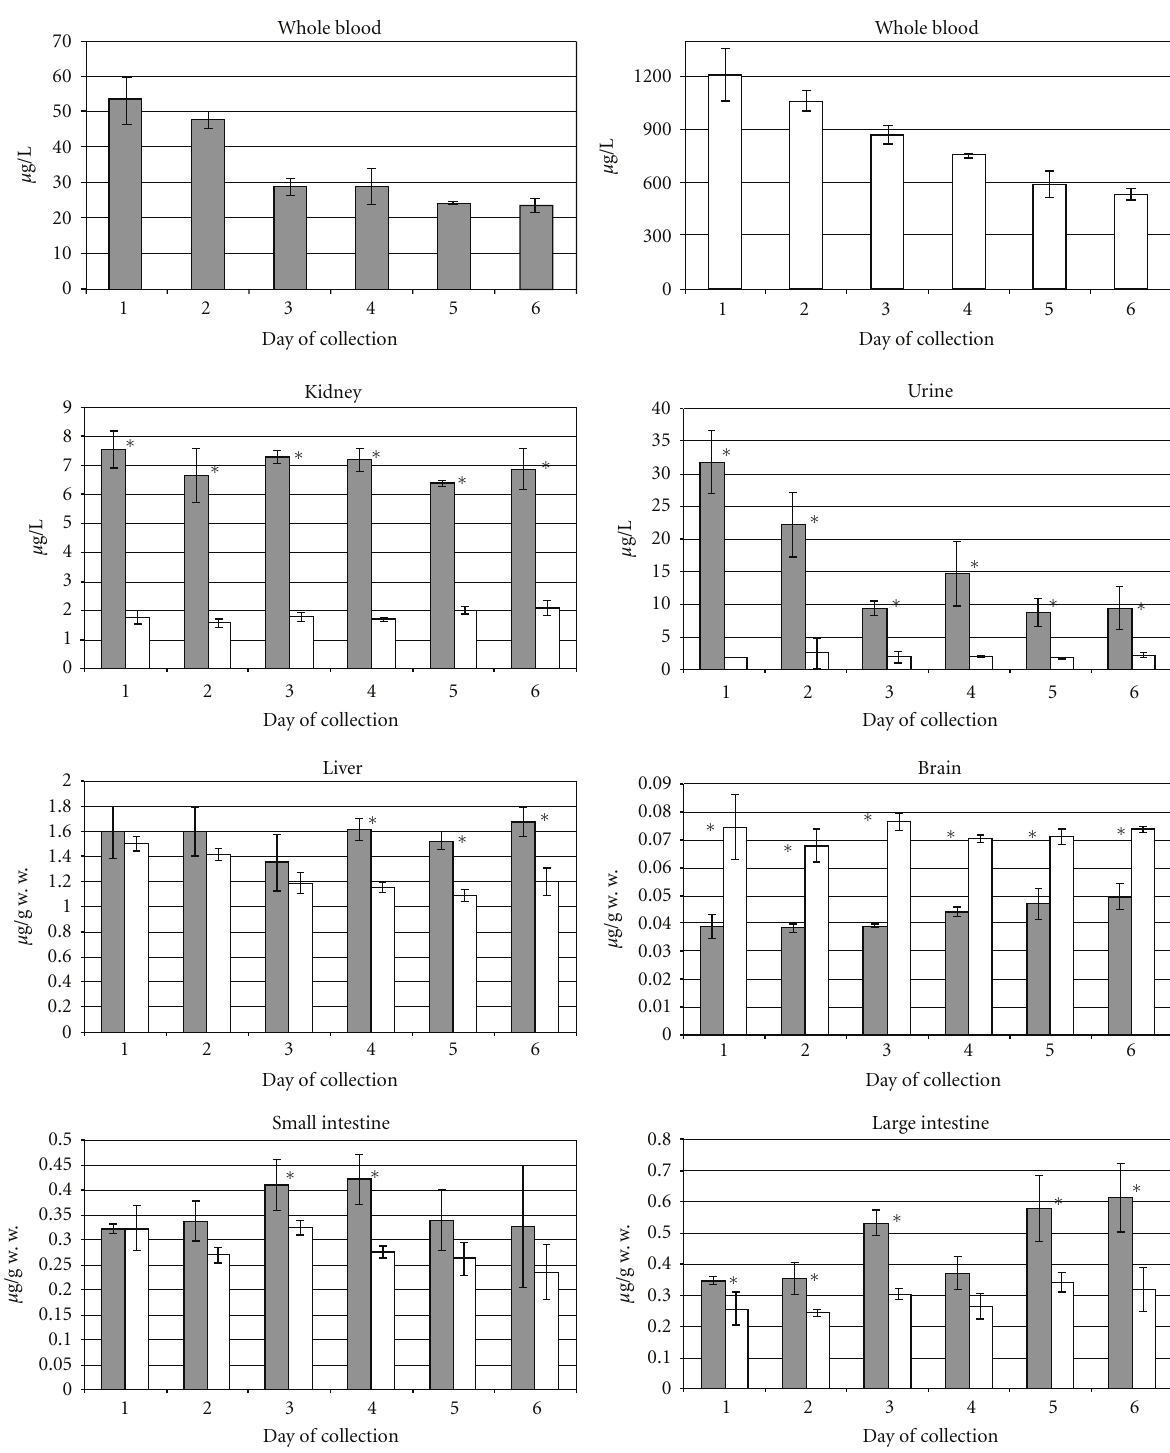
Figure 1: Concentrations in whole blood and urine and mass fractions of mercury in organs (kidneys, liver, brain, small intestine, and large intestine) of suckling rats exposed to mercuric chloride (HgCl 2 ; grey bars) or thiomersal (ethylmercury; white bars). Data are presented within six days after administration of either form of mercury as means ± SD; ∗ statistically significant di ff erence between exposed groups (at P < 0 .